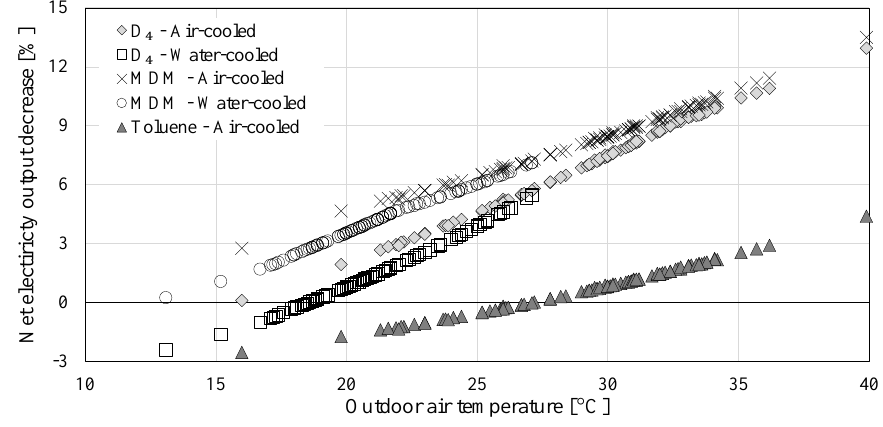
Figure 15. Net electricity output decrease as a function of nominal outdoor